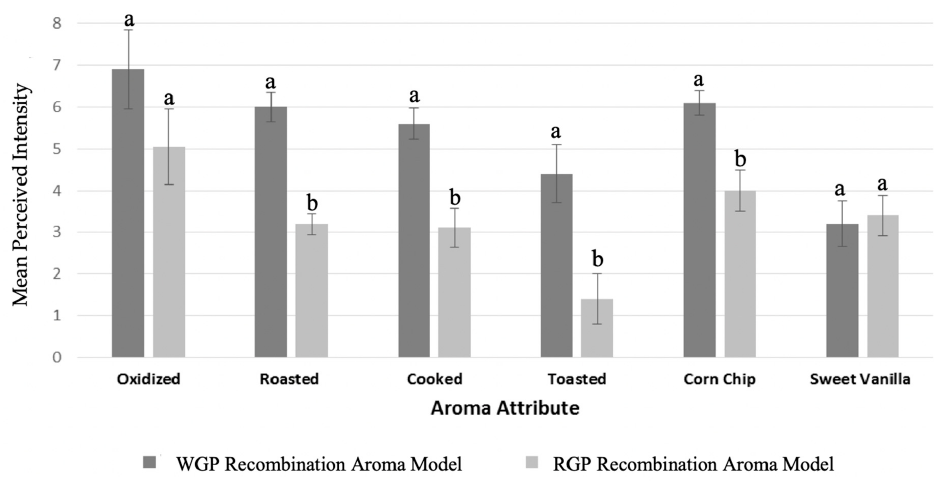
Figure 2. Mean aroma attribute intensity scores of aroma recombination models for extruded maize refined grain puffs (RGP) and whole grain puffs (WGP); Different letters (a, b) indicate a significant difference between samples for each attribute according to Tukey ′ s HSD, p < 0.05.